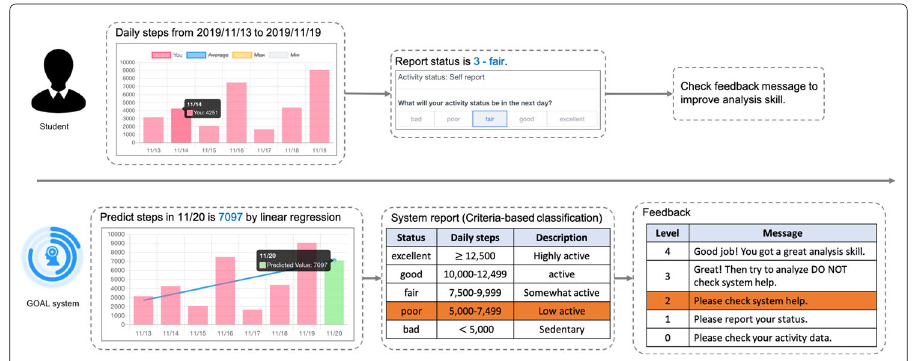
Fig. 5 Example of supporting analysis skill in physical context (4) 10,000–12,499 steps/day (active), and (5) ≥ 12,500 steps/day (highly active)